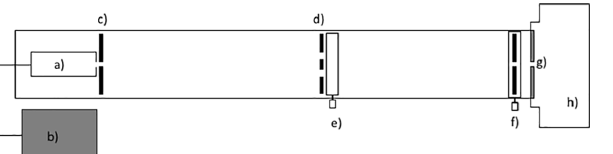
Fig 5. Optical bench. The optical bench consists of a sealed tube containing the following elements: a) light- emitting diode (LED) light source; b) pulsing system; c) optical filter; d) collimator; e) double slit; f) slit blocker with adjustable micrometers; g) detector slit; and h) shutter/ocular. A human eye can be positioned at the ocular, or it can be replaced by a photomultiplier (i). The distance between c) and h) is 890 mm, and the distance between e) and h) is 450